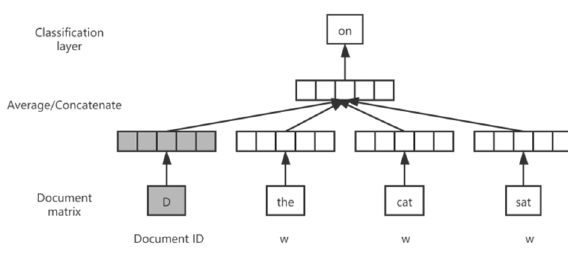
Figure 3. Structure of the PV-DBOW training sentence vector.